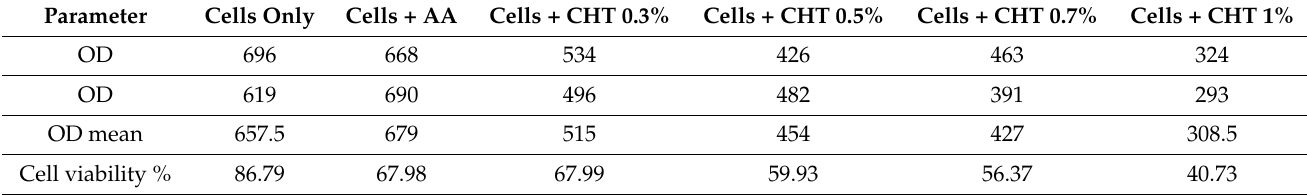
Table 3. E-11 viability test using MTT. The table includes viability percentages (%) of E-11 cells mock treated mock with L-15 medium only, E-11 cell treated with 2% acetic acid (AA) and E-11 cells treated with chitosan (CHT) dissolved in 2% AA at different concentration (0.3%, 0.5%, 0.7% and 1%).